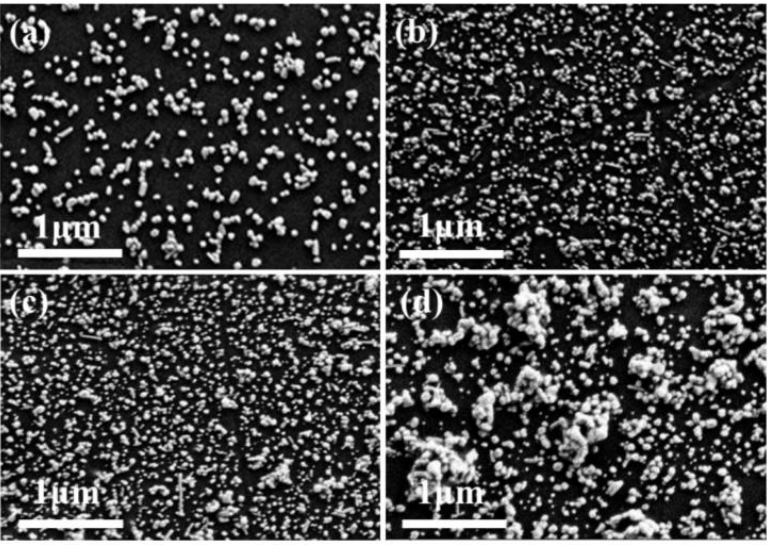
Figure 2. SEM images of substrates with different concentrations of phosphoric acid as the aggrega- tor: ( a ) 0 mM; ( b ) 0.02 mM; ( c ) 0.2 mM; ( d ) 2 mM. ( a ) 0 mM; ( b ) 0.02 mM; ( c ) 0.2 mM; ( d ) 2